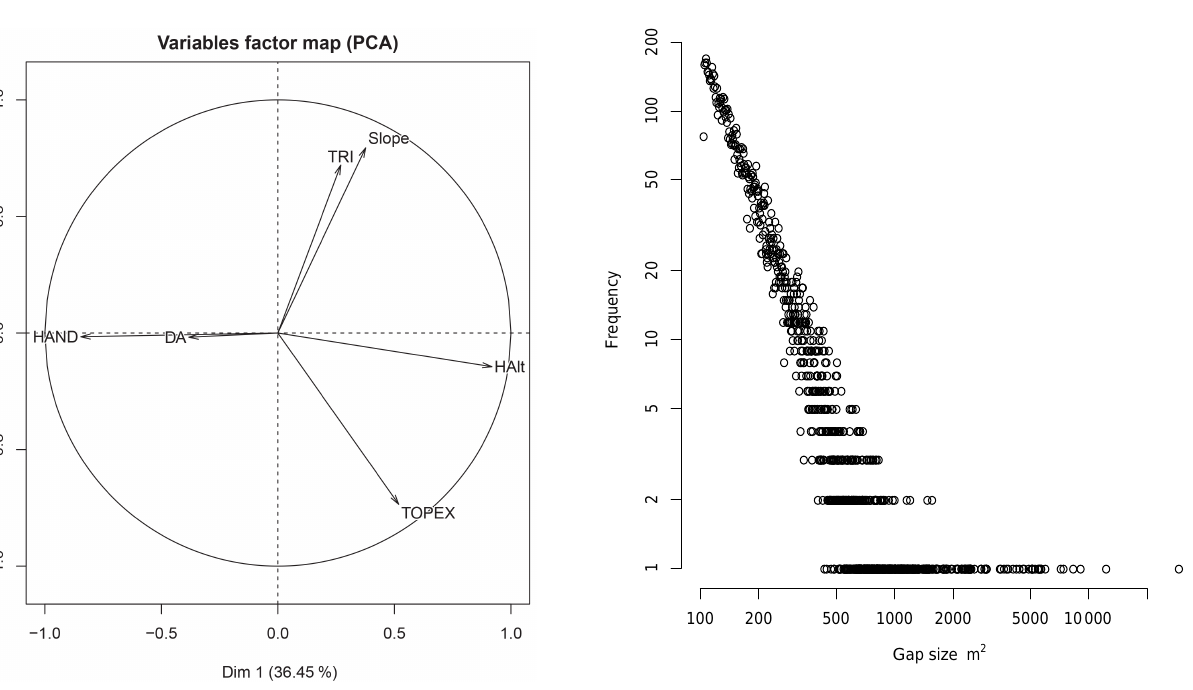
Figure 2. Results of the principal component analysis of the envi- ronmental variables.